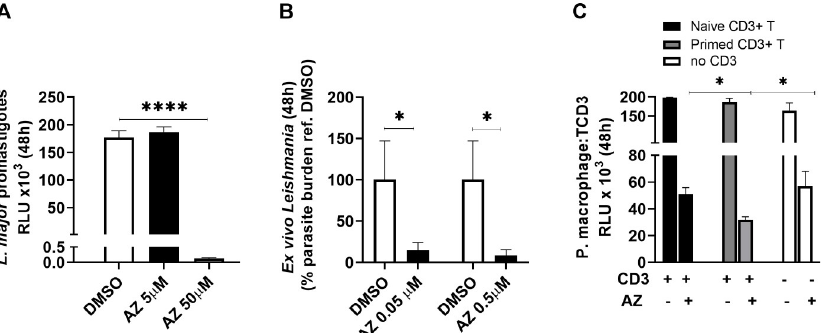
Fig 4. Activity of azelastine (AZ) against L . major . (A) promastigote numbers of L . major -LUC after 48 h of incubation at 26˚C exposed to either AZ or DMSO quantified by luminometry as relative light units (RLU; ���� p < 0.0001, Tukey’s multiple comparison test). (B), quantification of L . major in ex vivo cultures from infected mice using Leishmania 18s gene expression after 48 h of AZ exposure at 34˚C (data expressed with reference to untreated DMSO controls;. � p = 0.02, Mann-Whitney test). (C), anti-leishmanial activity of AZ in L . major -infected mouse peritoneal macrophages co-cultured with either na ï ve lymphocytes (black bars), Leishmania -primed lymphocytes (gray bars) or without lymphocytes (empty bars). Parasite burden was determined by luminometry (RLU) after 48 h of incubation at 34˚C ( � p < 0.05, Tukey’s multiple comparisons test).